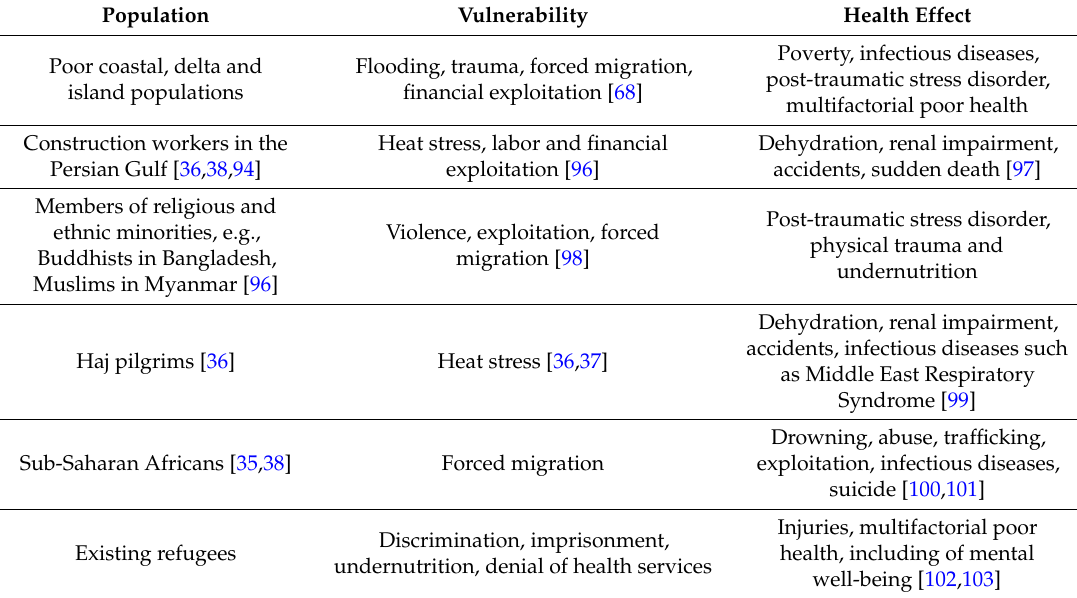
Table 2. In numerous ways, financially poor populations are vulnerable to adverse consequences of adverse environmental change. They are thus vulnerable to many adverse health effects, including impaired mental health, suicide, and other forms of self-harm, injuries, renal impairment, multifactorial poor health, and infectious diseases. The named groups and mechanisms are a small subset of the total